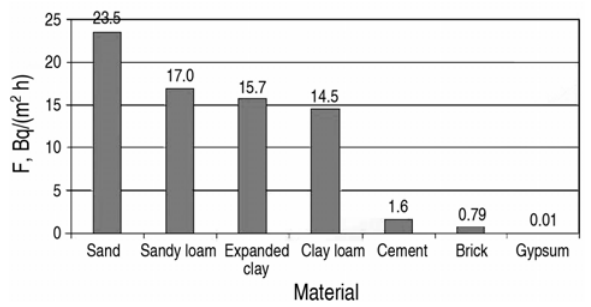
Fig 5 . Radon exhalation rate (F) from the soil and build- ing materials